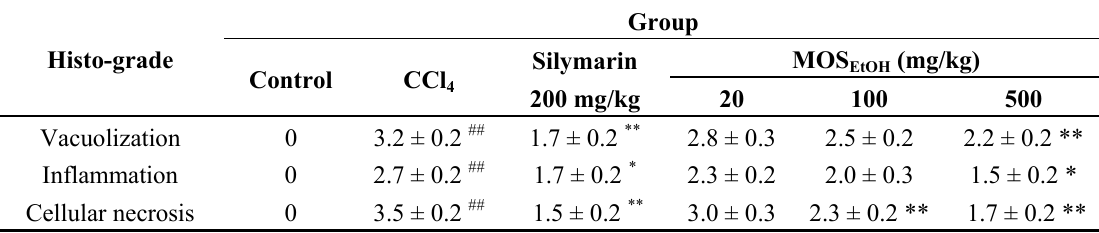
Table 2. Histoscores of livers treated with either silymarin or MOS CCl -induced hepatotoxicity 4